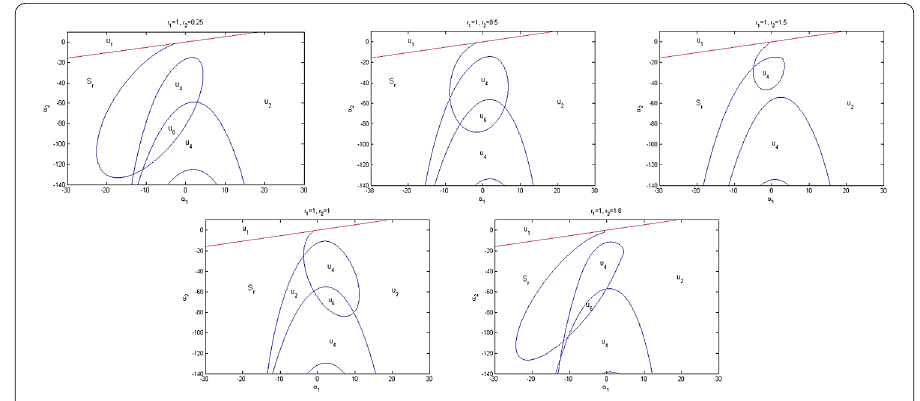
Figure 1 The D-curves and stability region of system (1)–(2) for β 1 = 1.4, β 2 = 0.4, θ 1 = 1.25, θ 2 = 1, r 1 = 1, and r 2 =